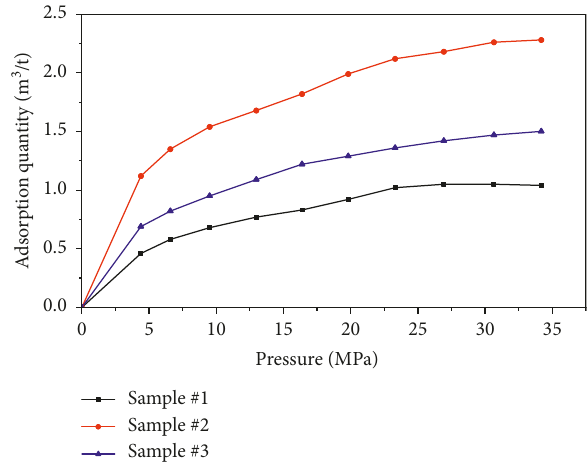
Figure 2: Isothermal adsorption curve of shale.